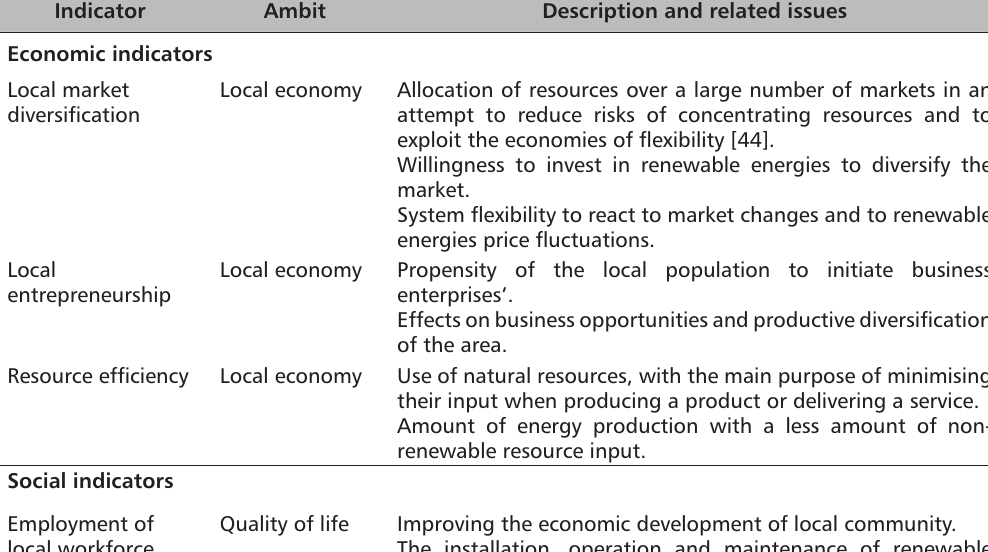
TABle 3. Socio-economic effects on local development considered in this paper (source: [37-47])